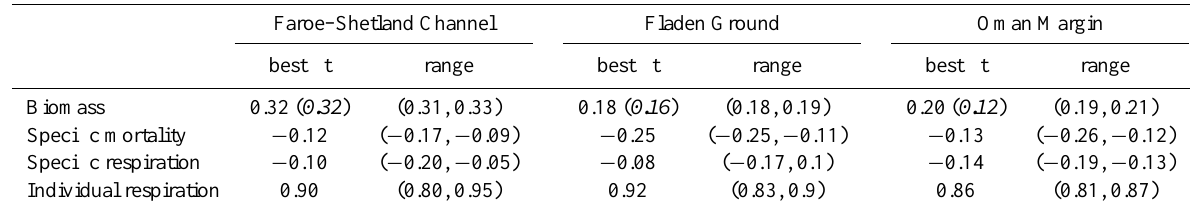
Table 5. Scaling exponents derived from model output, assuming a scaling of parameter = aW b , where W is nominal weight for class. For biomass, observed scalings are also given, in parentheses in italics.